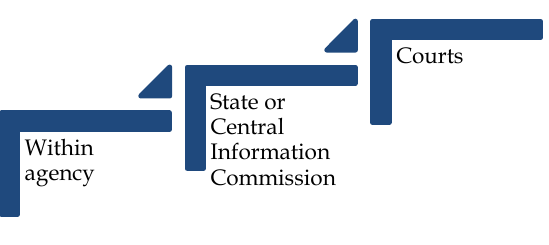
Figure 3: Levels of RTI Appeals in